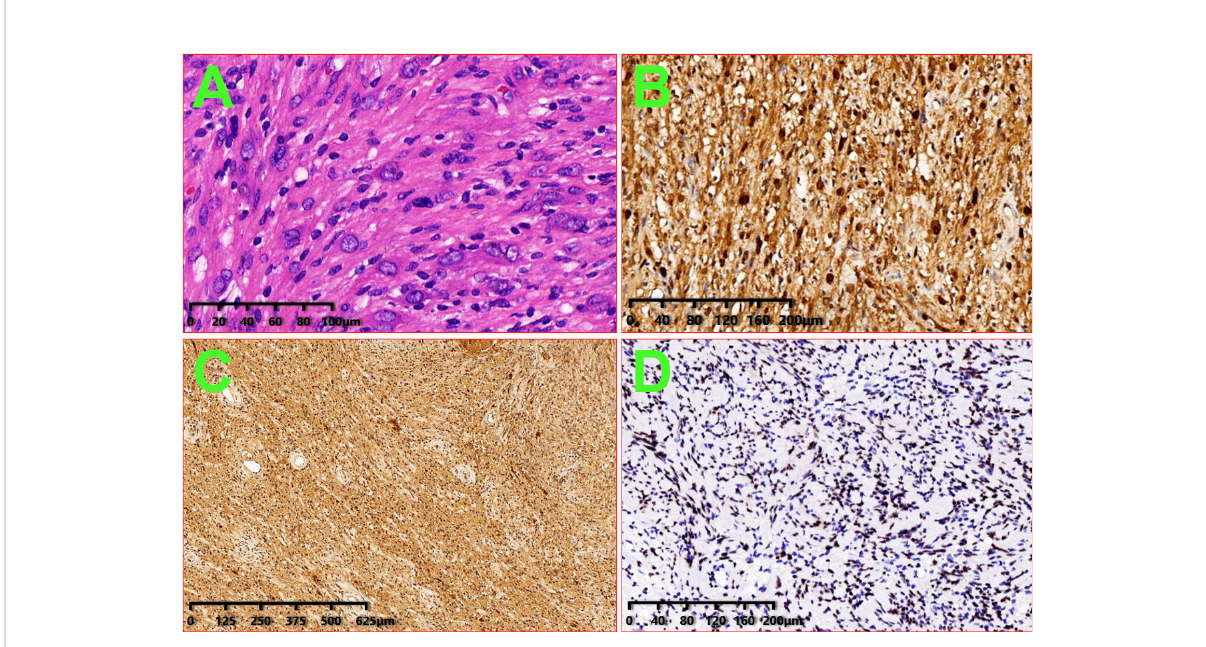
FIGURE 3 Image of histologic diagnosis from the left axillary mass. (A) : HE × 200; (B) : S100 × 100; (C) : PGP9.5 × 40; and (D) : SOX10 ×